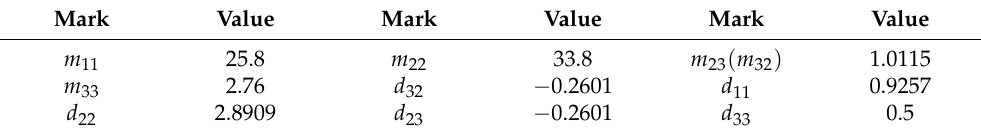
Table 1. Model parameters of the Cybership II.